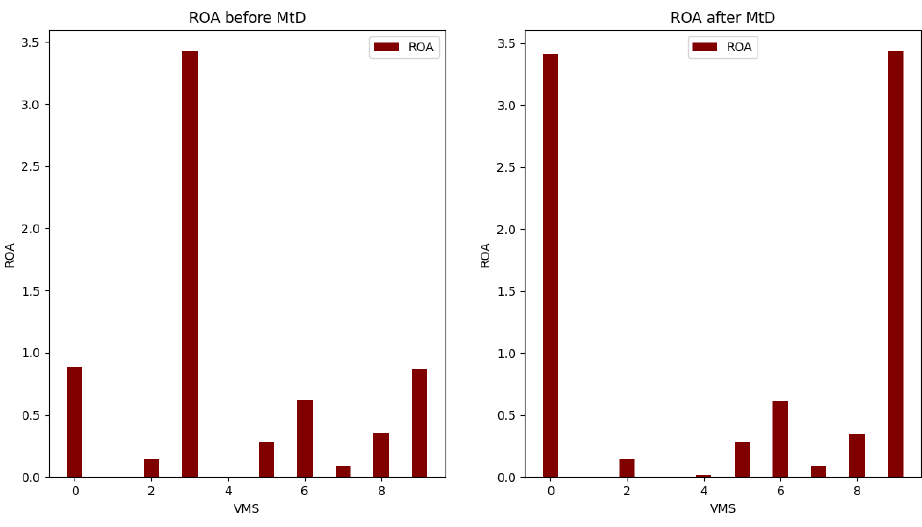
Figure 6. Comparison of ROA before and after applying shuffle